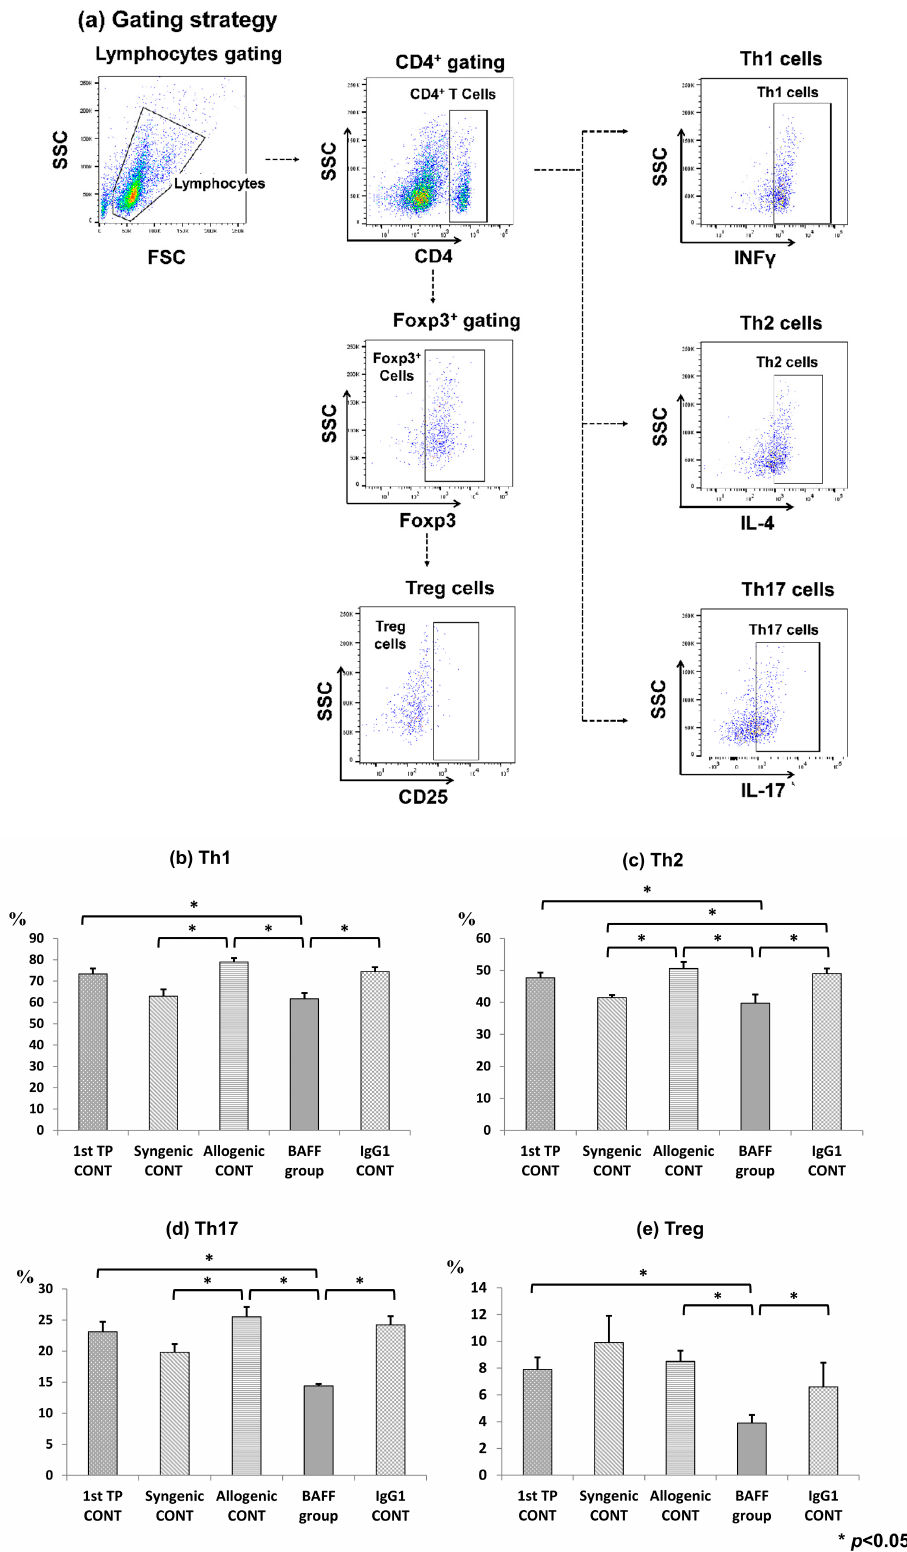
Figure 4. T cell population at week 9 (4 weeks after second transplantation) in the recipient spleen analyzed using flow cytometry. ( a ) Gating strategy and fractions of ( b ) CD4+/INF γ + Th1 cells, ( c ) CD4+/IL4+ Th2 cells, ( d ) CD4+/IL-17+ Th17 cells, and ( e ) CD4+/CD25+/Foxp3+ Treg cells. Error bars represent 2 standard errors (SE).